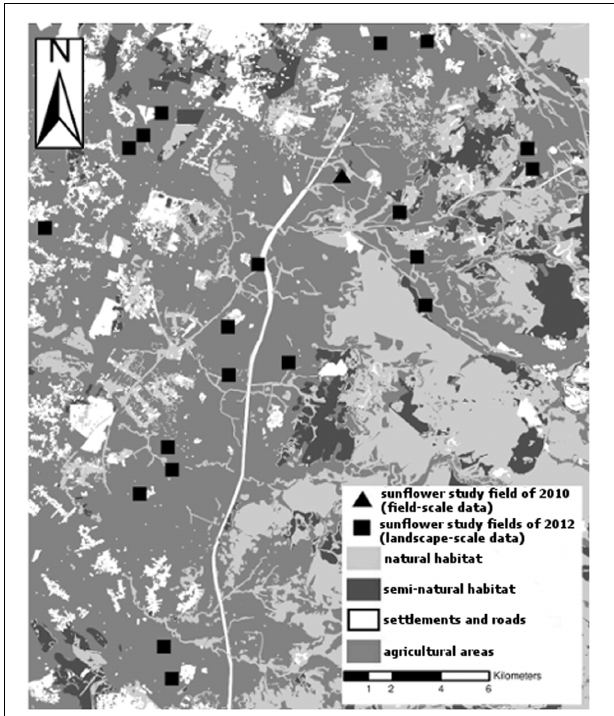
FIGURE 2 | Study area, habitat types and the distribution of the sunflower study fields at the field scale in 2010 and at the landscape scale in 2012 in the Judean foothills of